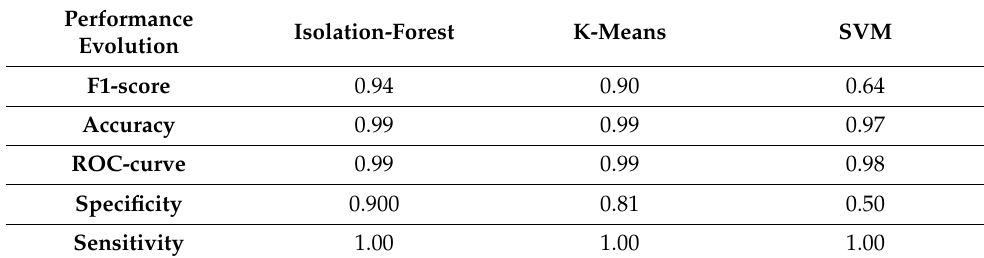
Table 13. Technique of performance evaluation.